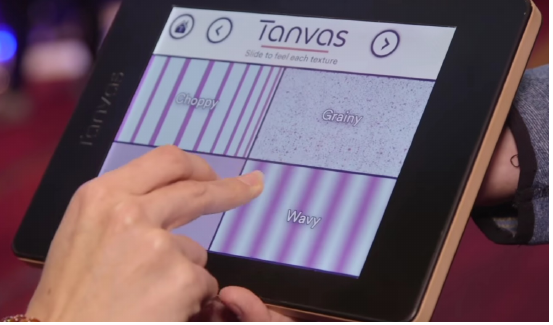
Figure 12. Tanvas tablet enable the user to feel different textures. This could be used to enhance the interaction with comics. Image downloaded from